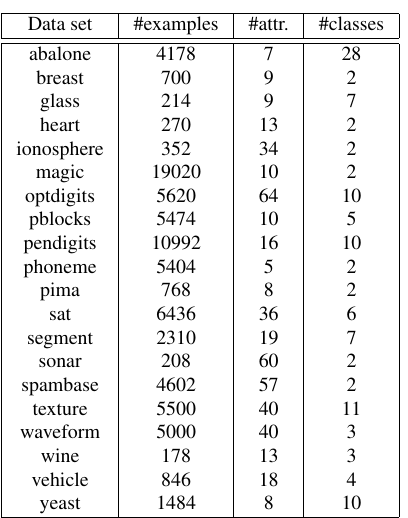
Table 2. Data sets